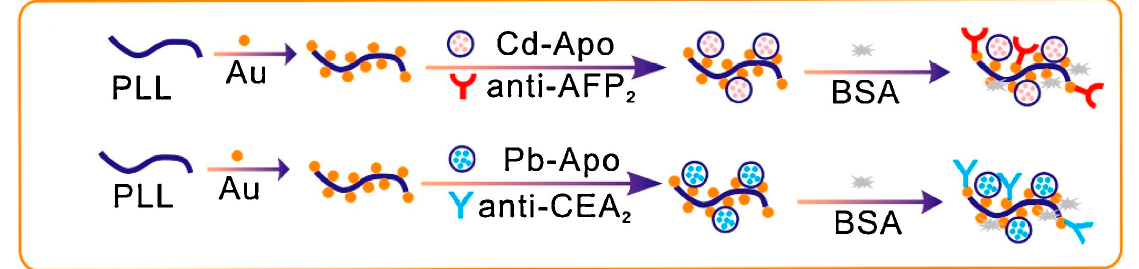
Figure 6. Preparation process of PLL-Au-Cd-Apo-Ab2 and PLL-Au-Pb-Apo-Ab2 signal tags. Reproduced with permission from